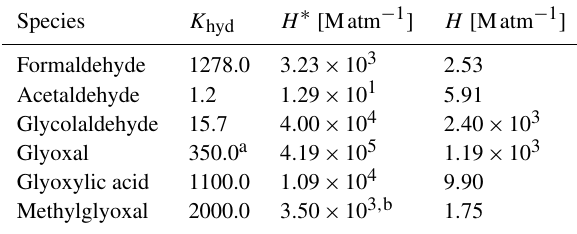
Table 1. Hydration constants ( K hyd ) and effective ( H ∗ ) and intrin- sic ( H ) Henry’s law constants for aldehydes (see Sect. 2.2 for de- tails). If not stated otherwise, hydration constants are obtained from Doussin and Monod (2013) and sources therein. If not stated oth- erwise, effective Henry’s law constants are taken from Burkholder et al.